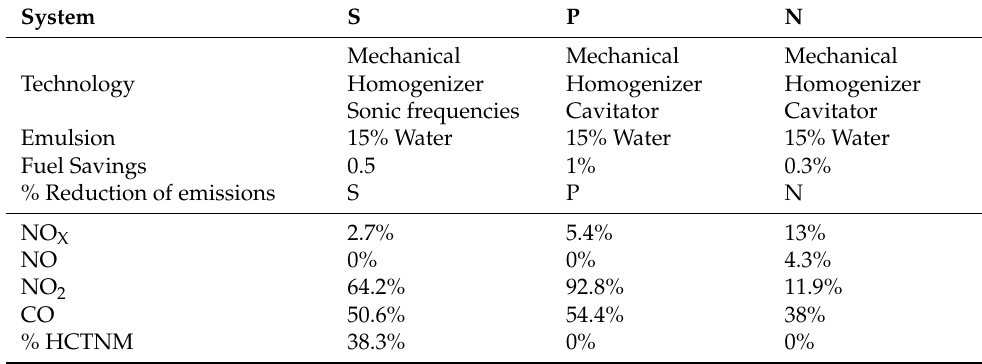
Table 8. Process model I.